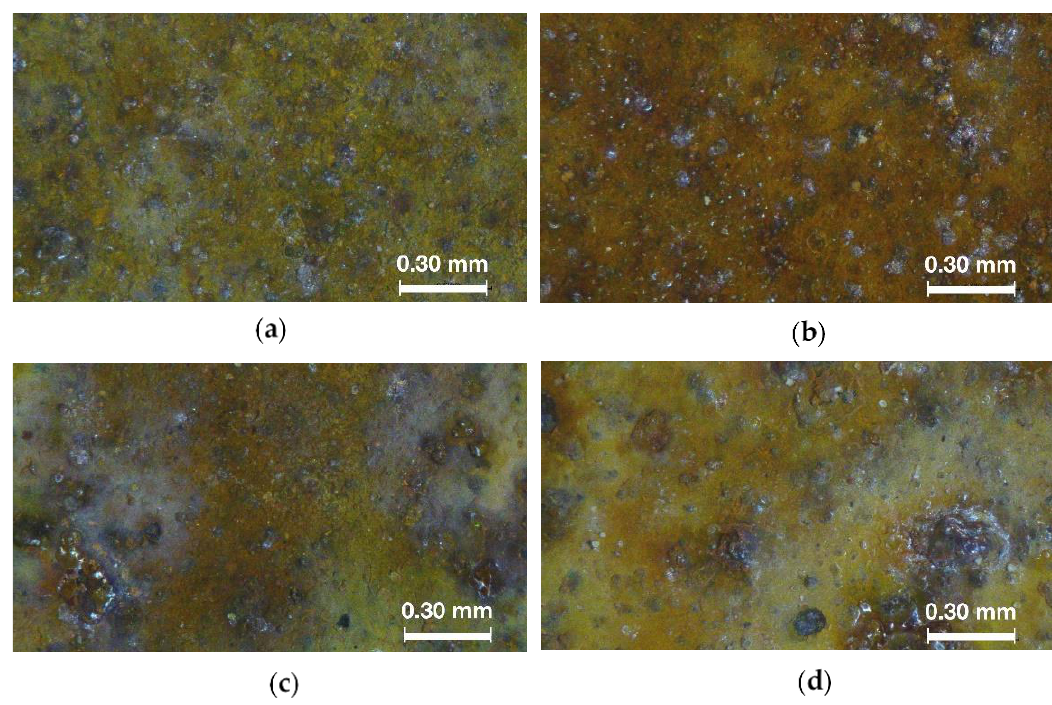
Figure 4. Optical microscope images of the natural patina developed after different exposure time to the Madrid atmosphere: ( a ) 3 months; ( b ) 6 months; ( c ) 12 months; and ( d ) 24 months. Table 3. Evolution of the L*, a* and b* coordinates of the natural patina with time at 95% confidence